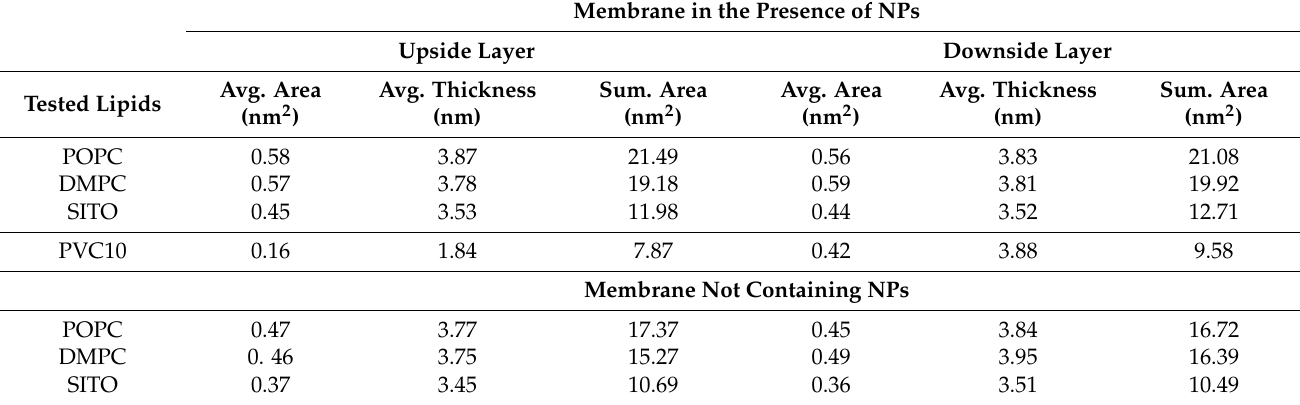
Figure 4. NPs alter the homeostasis of model membranes and lipids. ( A , B ) Partial density landscape for model membranes containing and not containing PVC10 NPs, respectively. ( C ) The average area versus time for all steps of model membranes containing (+ PVC10) and not containing ( − PVC10) NPs. ( D ) The average thickness versus time for all steps of model membranes containing and not containing NPs. ( E ) The average area of individual lipids versus time in the presence (+PVC10) and absence ( − PVC10) of NPs. ( F ) The average thickness of individual lipids versus time in the presence and absence of NPs. * indicates a significant difference in p < 0.05. Table 1. Effect of PVC10 NPs on membrane properties.